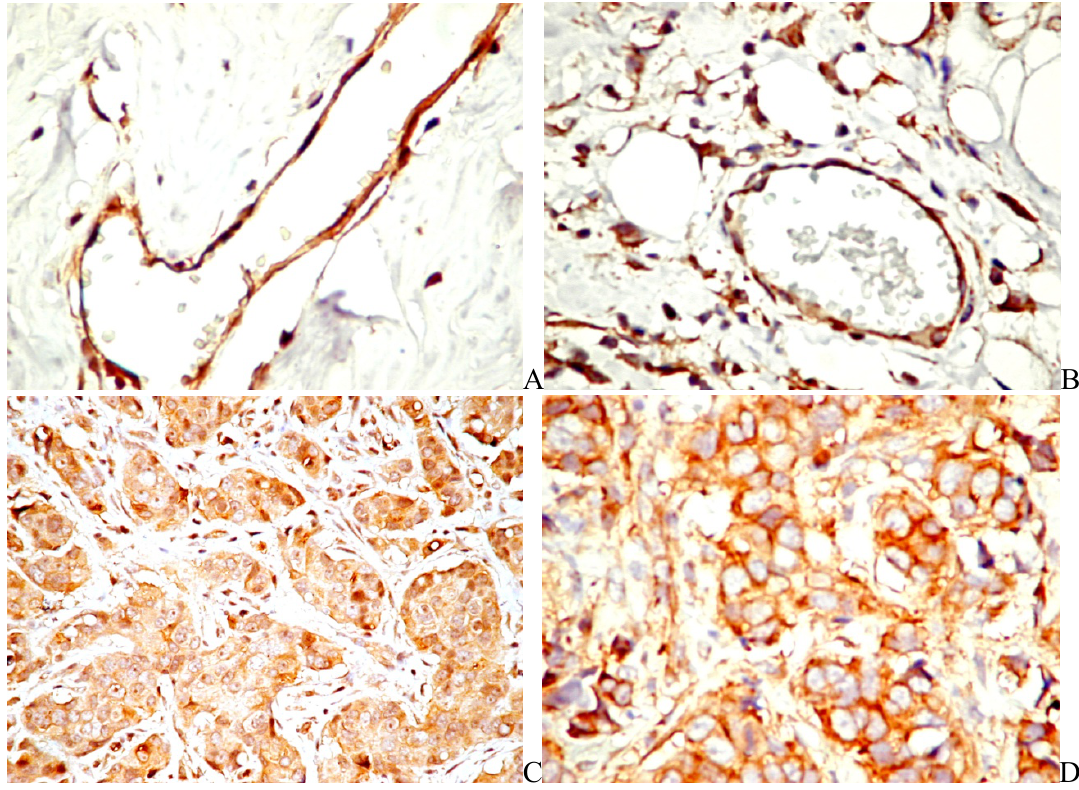
Figure 4. PDGFR α in the normal connective tissue (a, ×400). PDGFR β in the tumor stroma (b, ×400). PDGFR α expression in both breast tumor cells and stromal cells (c, ×200). PDGFR β expression in tumor cells from a breast invasive carcinoma (d,